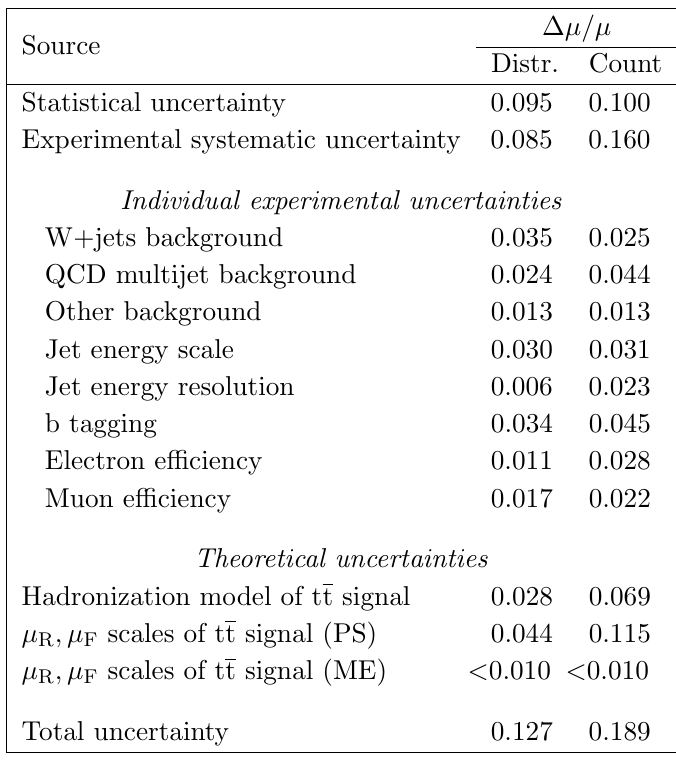
Table 2 . Estimated impact of each source of uncertainty in the value of (cid:22) extracted from the analysis of distributions, and in the cross-check from event counting. The \Other background" component includes the contributions from Z/ (cid:13) (cid:3) , tW, and WV events. The total uncertainty is obtained by adding in quadrature the statistical, experimental systematic, and theoretical uncer- tainties. The individual experimental uncertainties are obtained by repeating the (cid:12)t after (cid:12)xing one nuisance parameter at a time at its post-(cid:12)t uncertainty ( (cid:6) 1 standard deviation) value. The values quoted have been